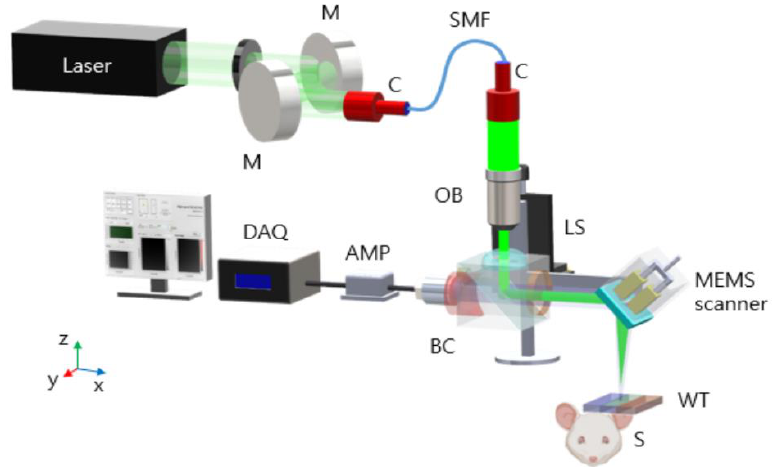
Figure 2. Diagram of optical resolution-photoacoustic microscopy. M, mirror; C, collimator; OB, objective lens; LS, linear stages; BC, beam combiner mirror; WT, water tank; AMP,